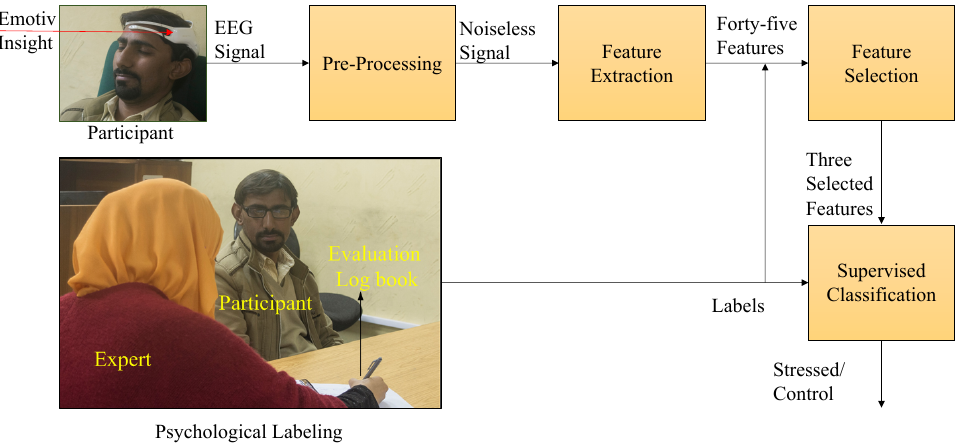
Figure 1. The proposed methodology for long-term human stress classification.